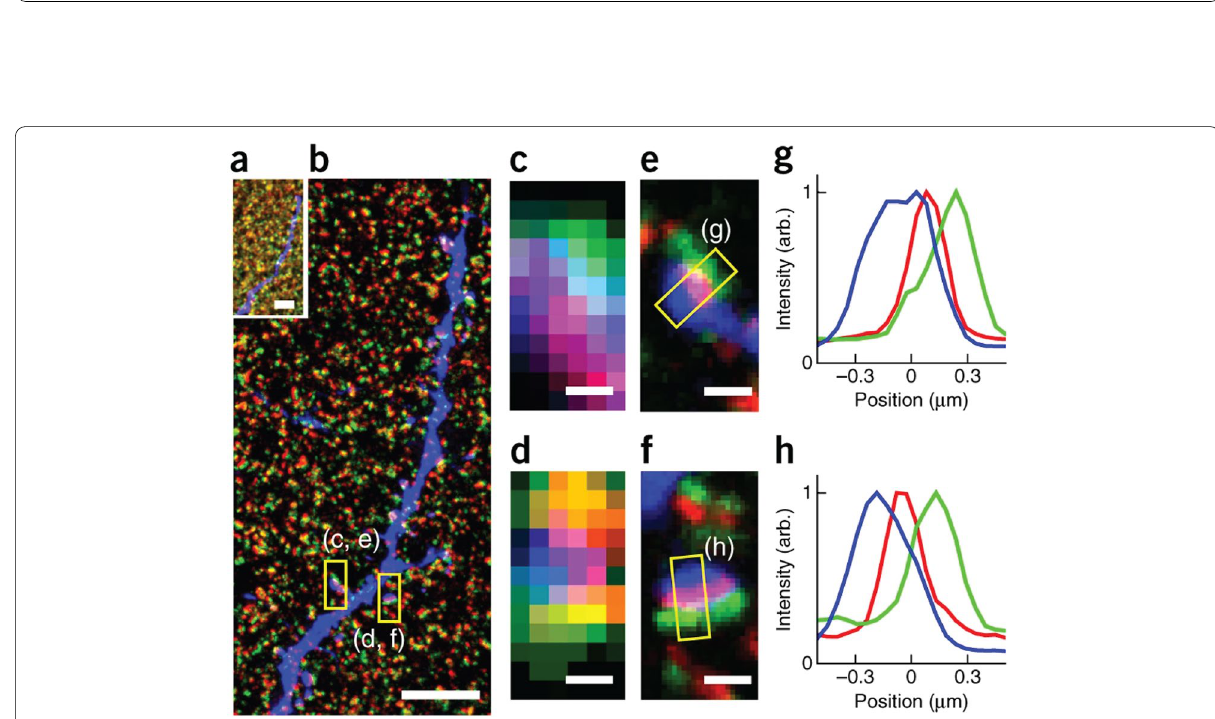
Fig. 5 Expansion of Thy1-YFP-H mouse brain slice using MA-NHS as the protein anchor. a Triple-color proExM of endogenously expressed YFP (blue), immunostained presynaptic marker Bassoon (green), and immunostained postsynaptic marker Homer1 (red). Scale bar, 5 μm. b The same area as in a after expansion. Scale bar, 5 μm. c , d Magnified views of the boxed regions before expansion. Scale bars, 500 nm. e , f The same area in c and d after expansion. Scale bars, 500 nm. g , h Cross-sectional profiles of the boxed regions in e and f (arb., arbitrary units). (Reprinted/adapted by permission from Springer Nature: Chozinski et al. [38], copyright